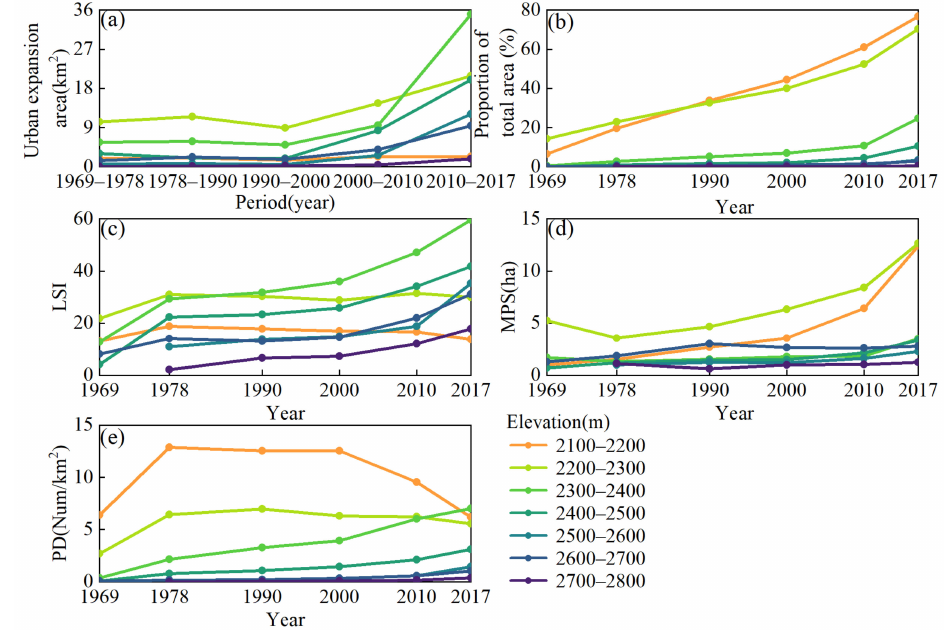
Figure 4. The characteristics of urban expansion at different altitudes. ( a ) urban expansion area; ( b ) changes in the proportion of urban land area; ( c ) changes in the urban landscape shape index; ( d ) changes in the average patch area of urban land; and ( e ) changes in the patch density of urban